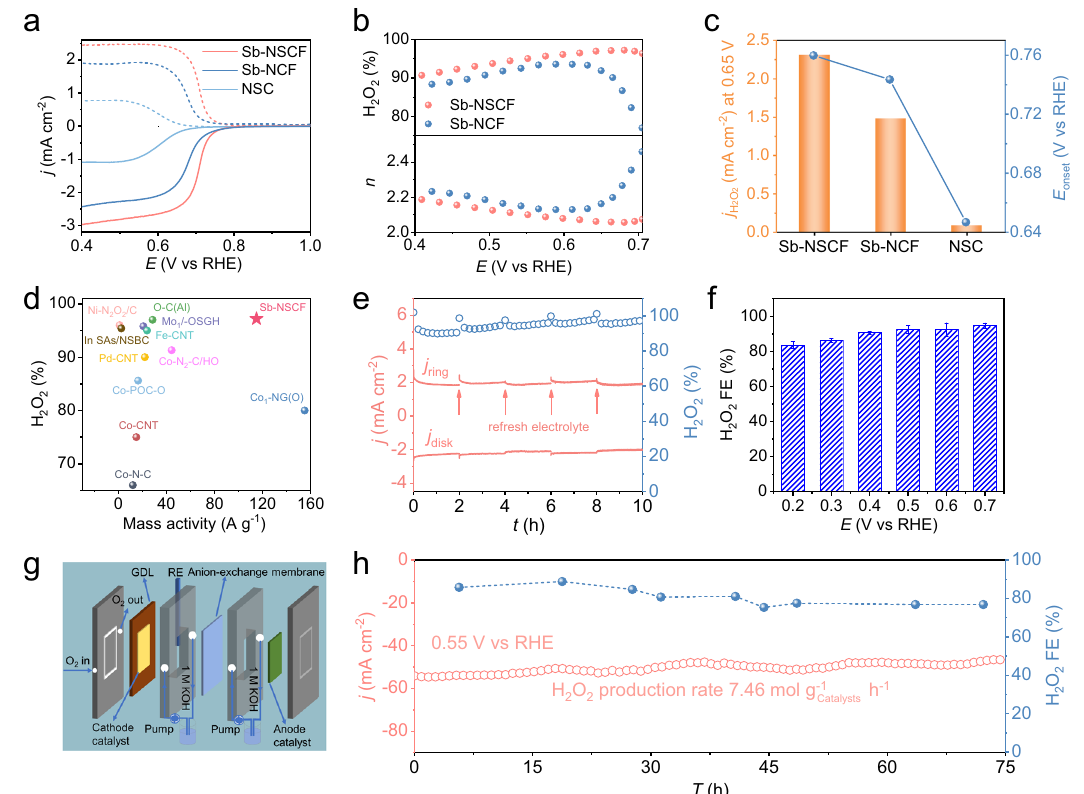
Fig. 4 | Electrocatalytic ORR performance. a Electrochemical oxygen reduction Table3. e ChronoamperometrystabilitytestofSb-NSCFat0.65Vin0.1MKOH.The Pt ring electrode was cleaned by cyclic voltammetry scanning from 0V to − 0.3V polarization curves (solid lines) at a rotation of 1600 rpm and simultaneous H 2 O 2 detection currents on the ring electrode (dashed lines) for Sb-NSCF, Sb-NCF, and versusRHEfor40cyclesandtheelectrolytewasrefreshedevery2hduringthetest. f TheH 2 O 2 Faradaicef fi ciency(%)ofSb-NSCFatdifferentpotentialsdeterminedby NSC in O 2 -saturated 0.1M KOH electrolyte. b Calculated H 2 O 2 selectivity (%) and electron transfer number ( n ) on Sb-NSCF and Sb-NCF based on the RRDE mea- the ceric sulfate titration method using the H-cell setup. g Illustration of the three- surements. c Comparison of H 2 O 2 current density ( j H phase fl ow cell setup for H 2 O 2 production. h Chronoamperometry stability test ) at 0.65V and onset 2 O 2 potentialat j